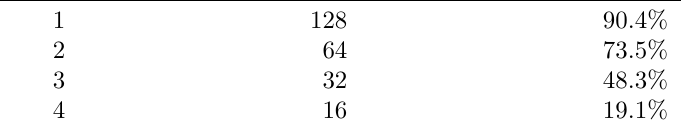
Table 3: The preservation rate of the Hamming weight of ∆ on folding multiple times for κ = 19 cold boot flips on Kyber